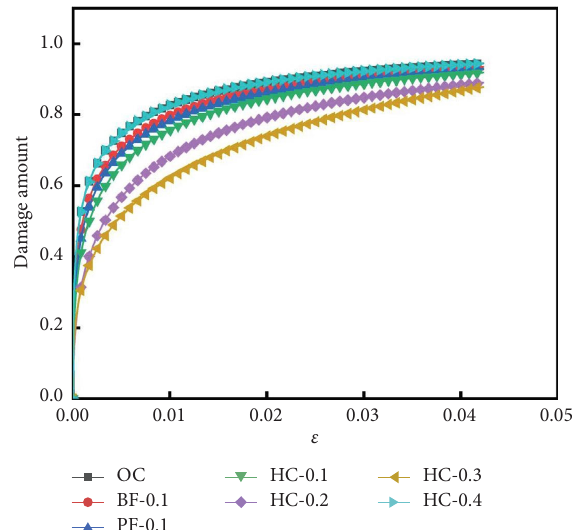
Figure 10: Damage evolution